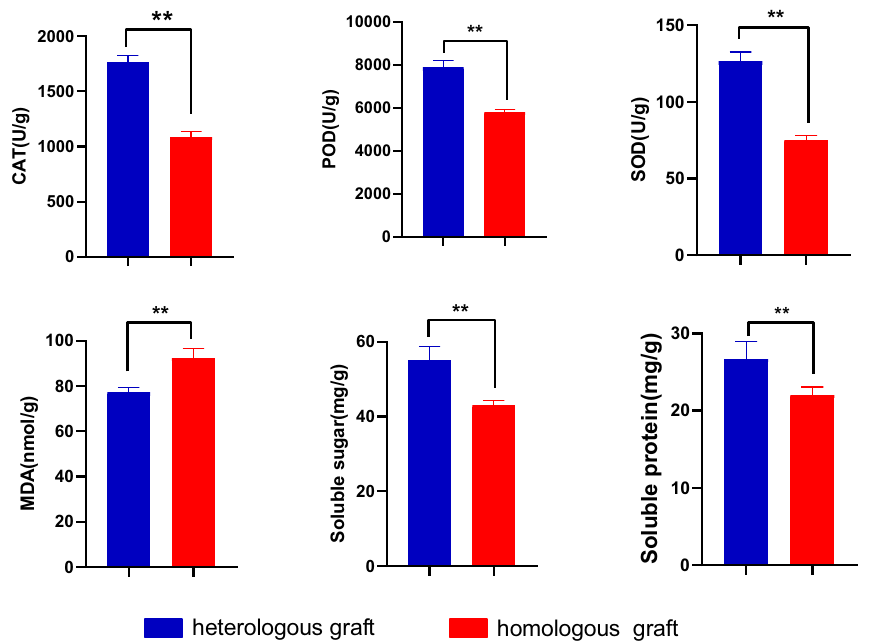
Figure 4. Catalase (CAT) activity, Superoxide dismutase (SOD) activity, Polyphenoloxidase (POD) activity, MDA, total soluble sugar and protein content in the scion leaves of two graft groups. A significant difference between grafted groups was indicated by ** ( P < 0.01) using the Student’ s